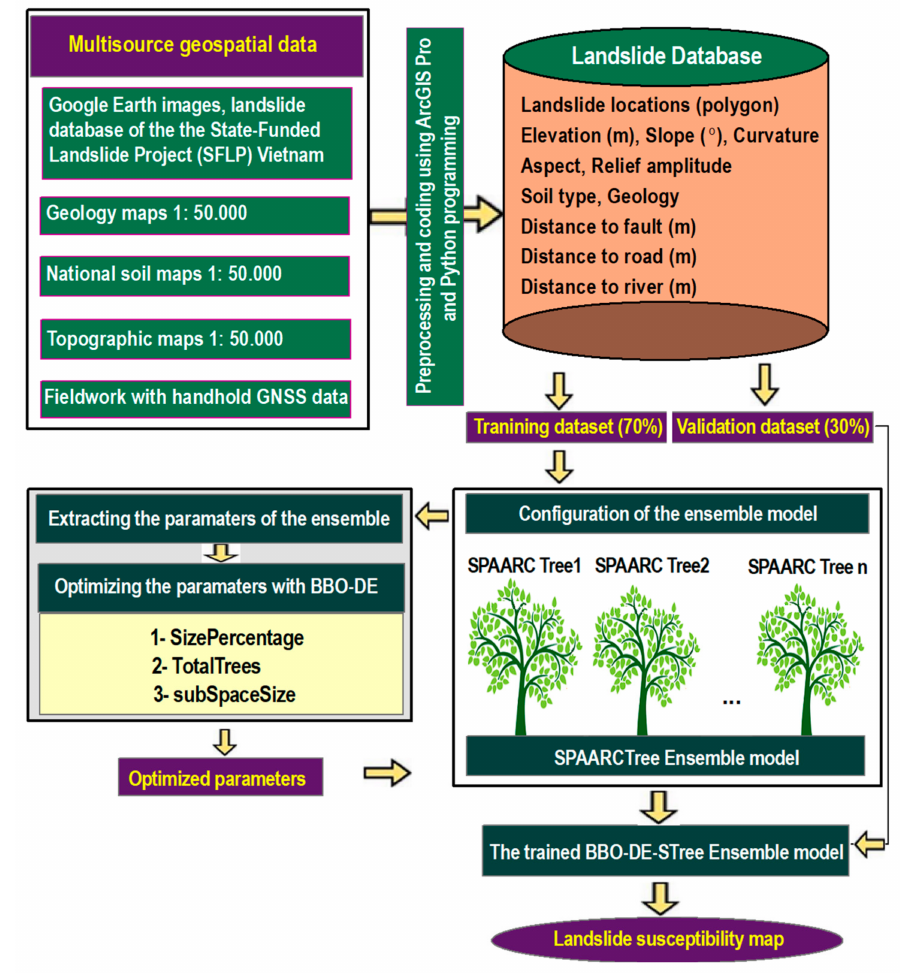
Figure 4. The flowchart of the proposed BBO-DE-STreeEns for landslide susceptible